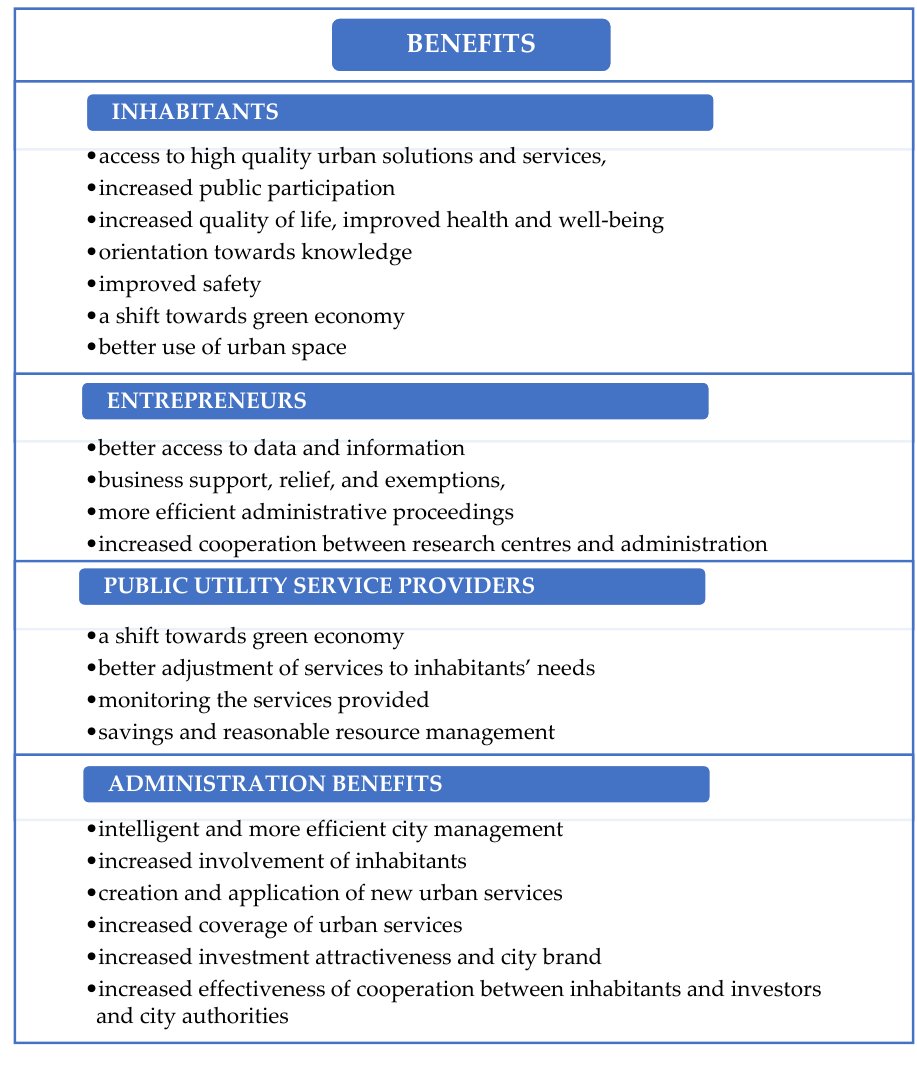
Figure 1. Benefits of having smart city status. Source: own study based on [27 – 32].